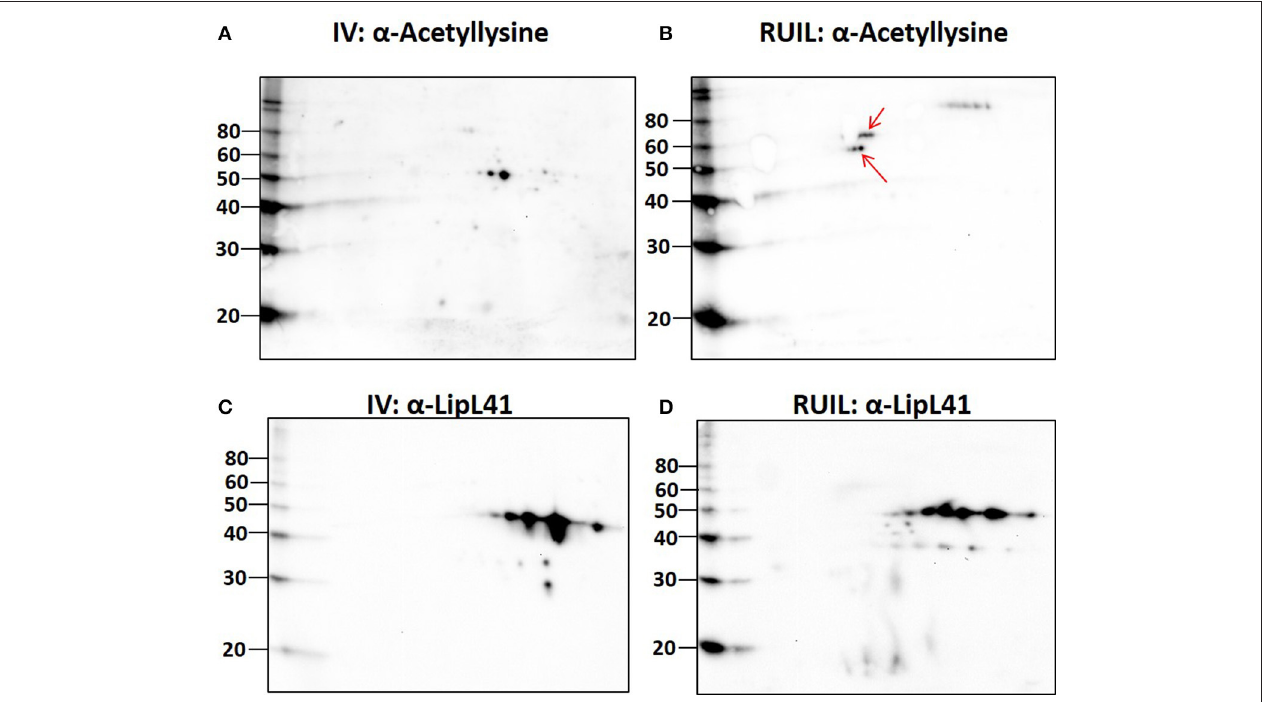
FIGURE 5 | 2-D Immunoblot analysis of in vitro (30 ◦ C; IV) and rat urine isolated (RUIL) leptospires. Approximately 2 × 10 7 or Strain RJ19115 leptospires were separated by 2-D gel electrophoresis and probed with antiserum specific for acetyllysine (A,B) or LipL41 (C,D) . Arrows indicate antigens reactive with anti-acetyllysine that are expressed by DMC- but not IV30-cultivated leptospires. Molecular mass markers (kDa) are